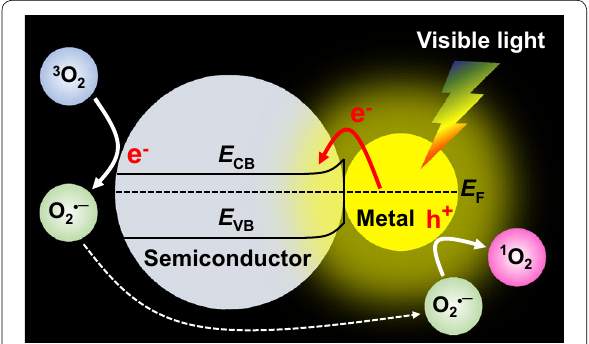
Fig. 1 Schematic illustration of a plausible mechanism for generating O 2• ‒ and 1 O 2 (i.e. O 2 ( 1 Δ g )) on metal–semiconductor hybrid nanostruc‑ tures via hot electron transfer caused by surface plasmon resonance upon visible light excitation. E CB and E VB represent the conduction and valence bands of the semiconductor photocatalyst, respectively. E F refers to the Fermi energy